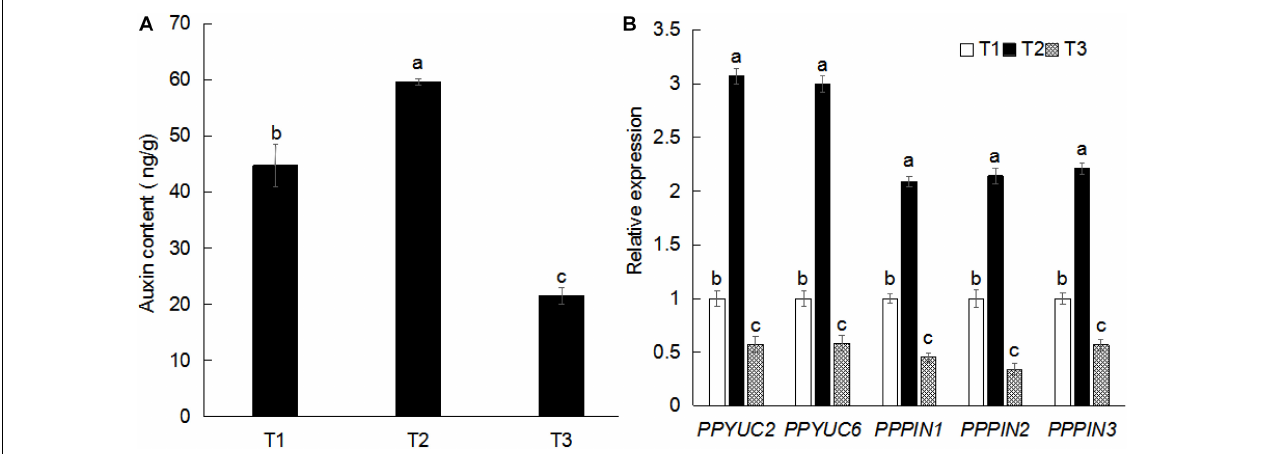
FIGURE 3 | Effects of exogenous sucrose on auxin content (A) and gene expression (B) in plant roots. Error bars represent the averages of three biological replicates ± SD. Different letters represent differences between different processes. Significance was defined at P < 0.05. T1, water; T2, 5% sucrose solution; T3, 5% mannitol solution.